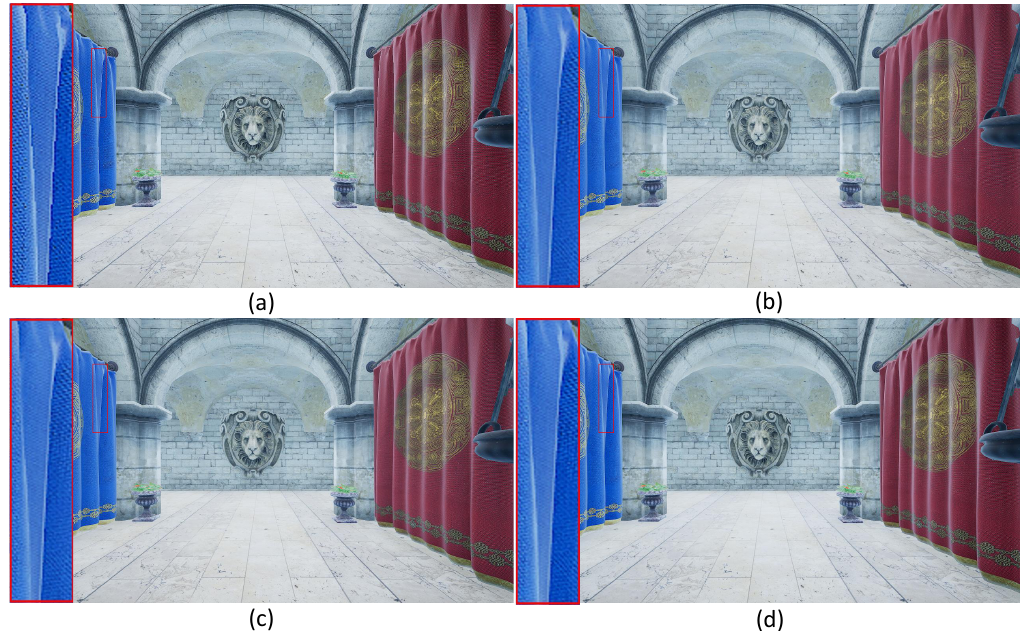
Figure 11. The effect contrast of no AA ( a ), FAXX ( b ), temporal anti-aliasing (TAA) ( c ), and our method ( d